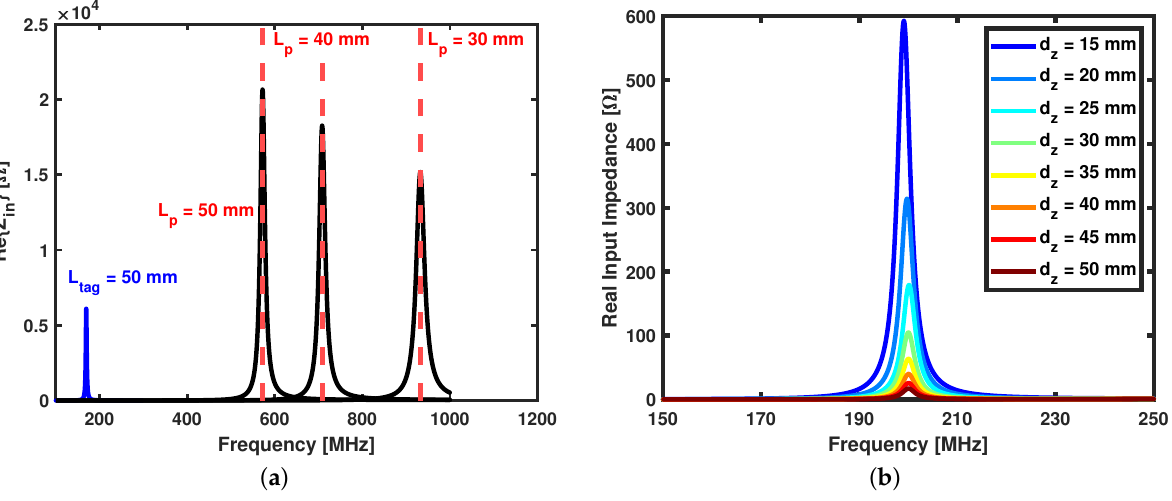
Figure 1. SR-based distance sensor presented in [27]. ( a ) 3D view of the sensor setup. ( b ) Top view of the SR. ( c ) Equivalent circuit model of the sensor; the SR is modeled using the series RLC circuit (right side) coupled to the probing loop by the mutual inductance, M .